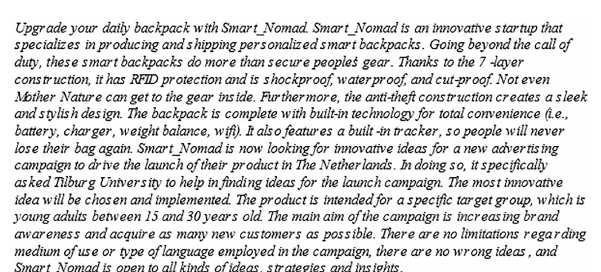
FIGURE 1 | Briefing about the creative problem that needed to be